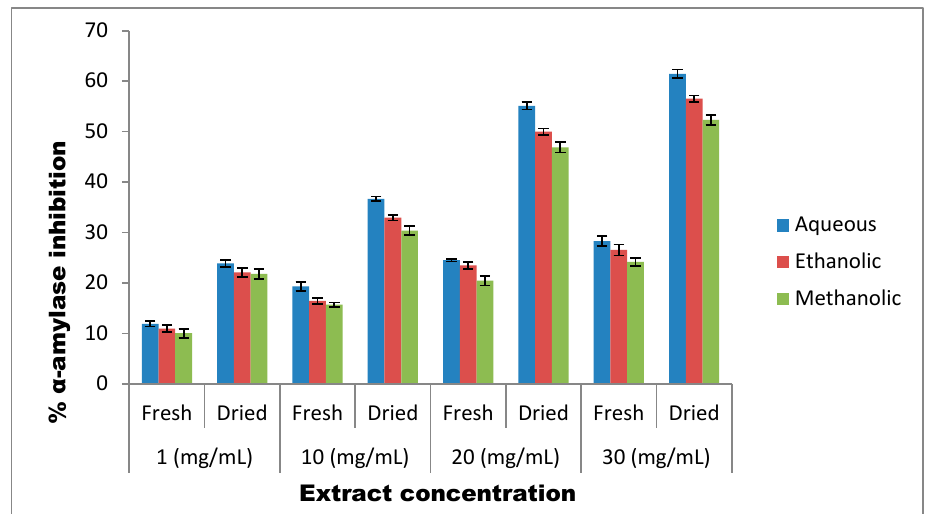
Figure 2. Inhibitory potential of T. officinale extracts against α -amylase. Further, 1 mg/mL, 10 mg/mL, 20 mg/mL and 30 mg/mL of aqueous extracts of fresh leaves demonstrated 10.95%, 19.34%, 26.56% and 31.55% inhibition of α -amylase activi- ty, respectively. Comparatively, the aqueous extract of shade-dried leaf samples proved more effective and caused 23.89% (118% increase), 36.68% (89.6% increase), 55.12% (107% increase) and 61.44% (94.7% increase) inhibition of α -amylase while using differ- ent concentrations i.e., 1 mg/mL, 10 mg/mL, 20 mg/mL and 30 mg/mL, respectively, of this extract. Likewise, the ethanolic extracts of fresh T. officinale leaves demonstrated 11.53%, 16.49%, 23.50% and 28.31% inhibitory potential against α -amylase as compared to 22.11%, 32.95%, 47% and 56.50% α -amylase inhibitory potential demonstrated by dried T. officinale leaves, at the respective concentrations of 1 mg/mL, 10 mg/mL, 20 mg/mL and 30 mg/mL. In the case of methanolic extracts of T. officinale leaves, the inhib- itory potential of the fresh form against α -amylase activity was also found to be much lower, i.e., 10.95% 15.72%, 23.47% and 26.18% as compared to the dried form, which demonstrated 21.82%, 31.39%, 46.89% and 52.30% α -amylase inhibitory potential at the respective concentrations of 1 mg/mL, 10 mg/mL, 20 mg/mL and 30 mg/mL. Moreover, found to be 59.78 ± 5 (Figure 3) . Figure 3. The IC 50 value of aqueous extract of shade-dried T. officinale leaves against α